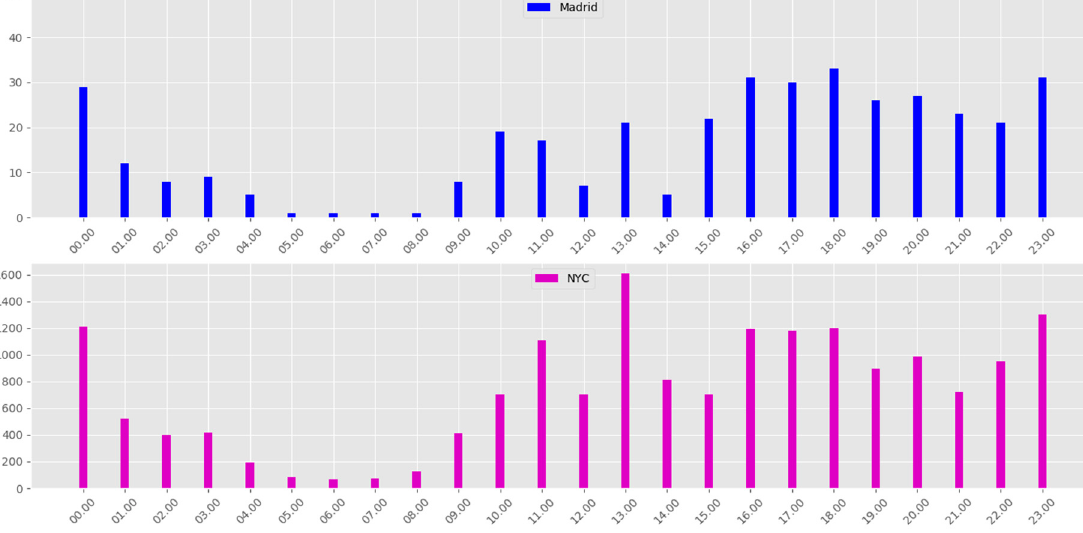
Figure 5. NYC and Madrid city clustering results on a special day.